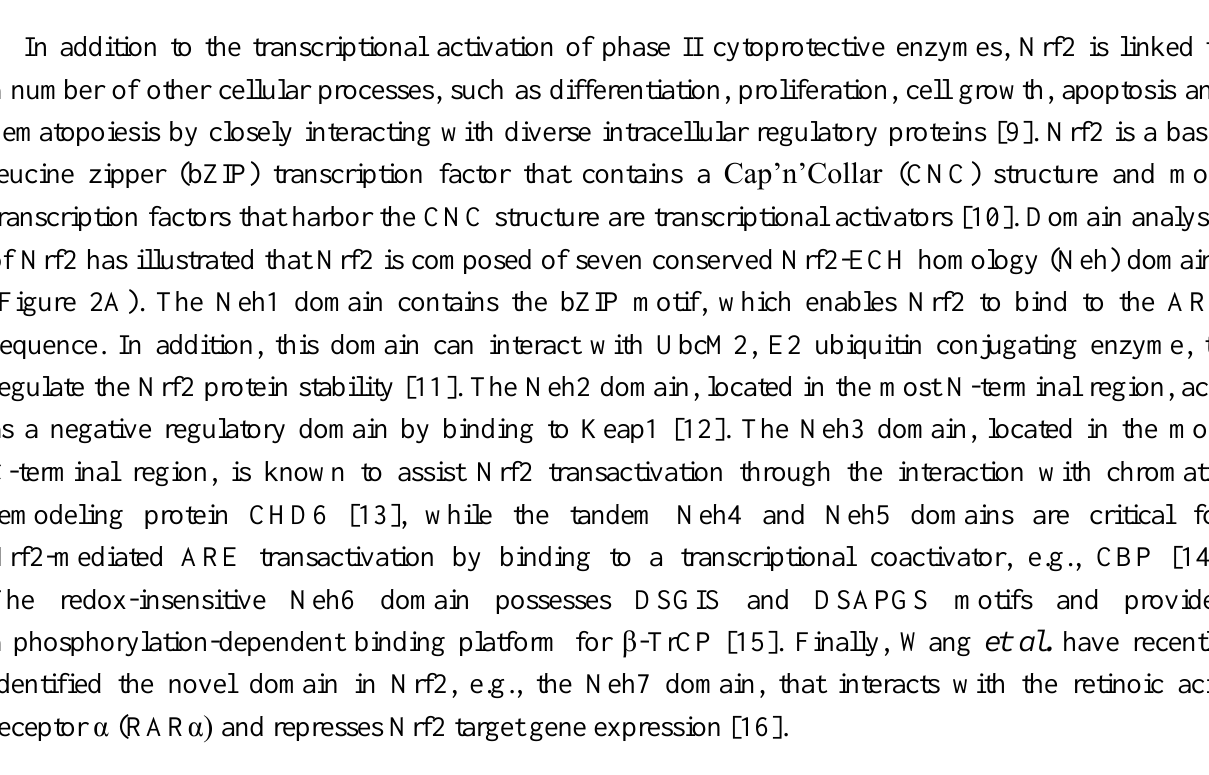
Figure 2. Conserved Domains of Nrf2 and Keap1 Proteins. ( A ) Nrf2 contains seven Neh domains (Neh1-7), in which the Neh1 domain binds to DNA using the bZIP motif and